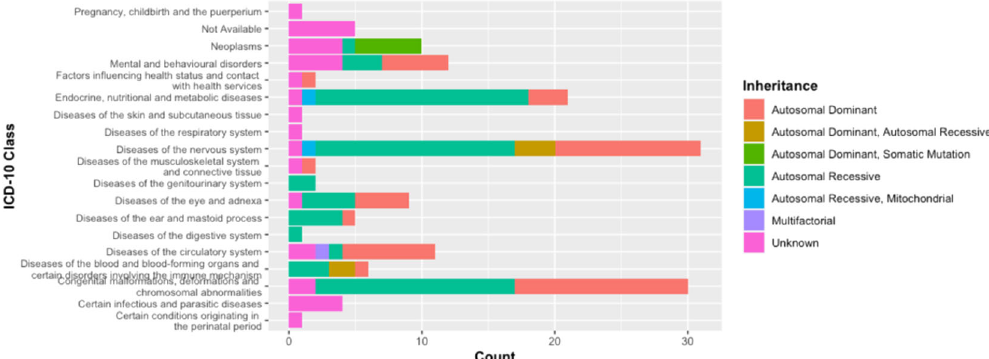
Fig. 5 WHO ICD-10 classi fi cation of diseases caused by CNV genes. Three major disease groups are caused by CNV genes. Disease classes are colored according to the inheritance Table 3. KEGG pathways enriched in genes affected by CNVs in the Tunisian population. KEGG pathway Number of genes Fold enrichment